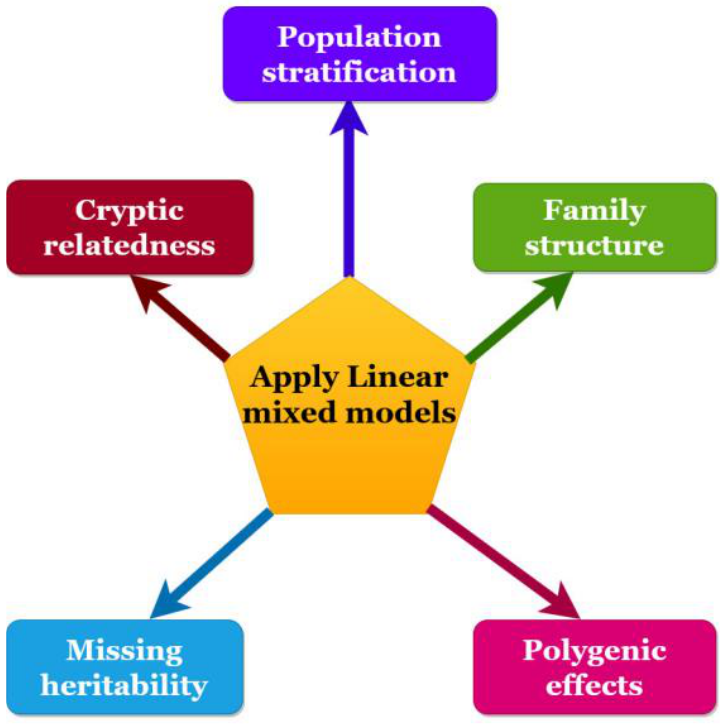
Figure 1. Problems solved by LMMs in GWAS for dissecting complex traits.